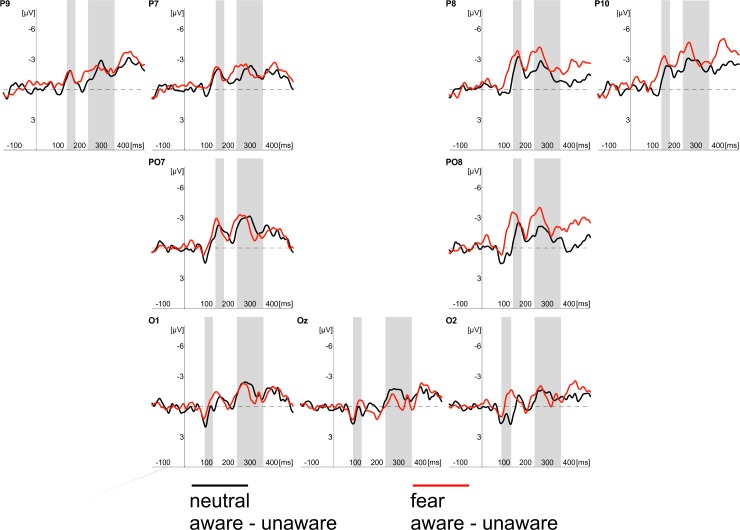
Difference waves computed as differences between aware and unaware conditions recorded in the PDW task at occipital (O1, Oz, O2) and occipito-temporal (P7, PO7, P9, P8, PO8, P10) electrodes in response to neutral (black lines) and fearful faces (red lines).Time windows for the region of interest (P1 component; 90-115ms post-stimulus; N170 component; 145-180ms post-stimulus; EPN component 240–340 ms post-stimulus) are highlighted at corresponding electrodes; time 0 indicates stimulus onset.